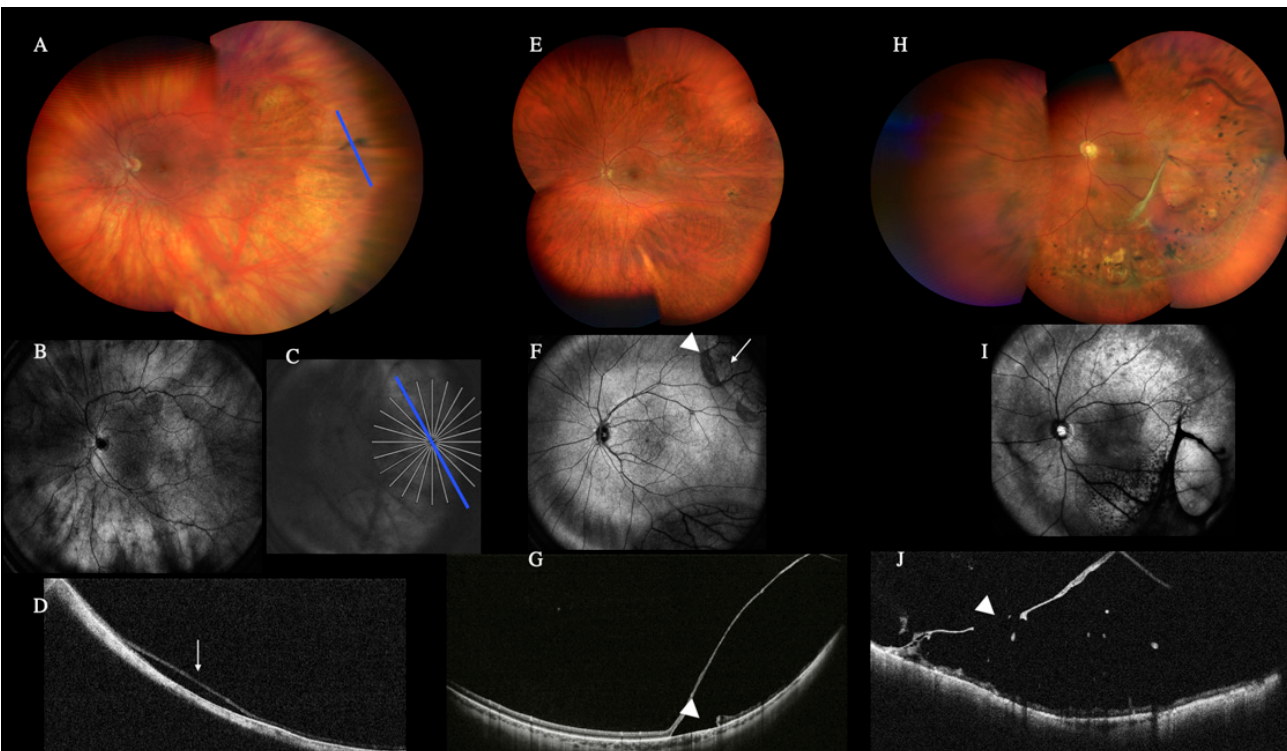
Figure 2. Color fundus retinography ( A ) and scanner laser ophthalmoscopy (SLO) image ( B , C ) of a peripheral temporal retinal detachment that could only be diagnosed on the wide-field optical coherence tomography (WF-OCT) ( D ) (arrow). Peripheral retinoschisis is visualized in the color fundus retinography ( E ) and SLO image ( F ). The two different areas seen in the SLO image ( F ) allowed us to differentiate the retinoschisis area (arrow) from the retinal detachment area (arrowhead). With the WF-OCT ( G ), an outer retinal break and a contiguous area of retinal detachment (arrowhead) can be seen. This limited retinal detachment was missed with the fundus retinography. Color fundus retinography ( H ) SLO image ( I ) and WF-OCT ( J ) of a peripheral retinoschisis with vitreous tractions and internal retinal break (arrowhead) that could be better visualized with WF-OCT.